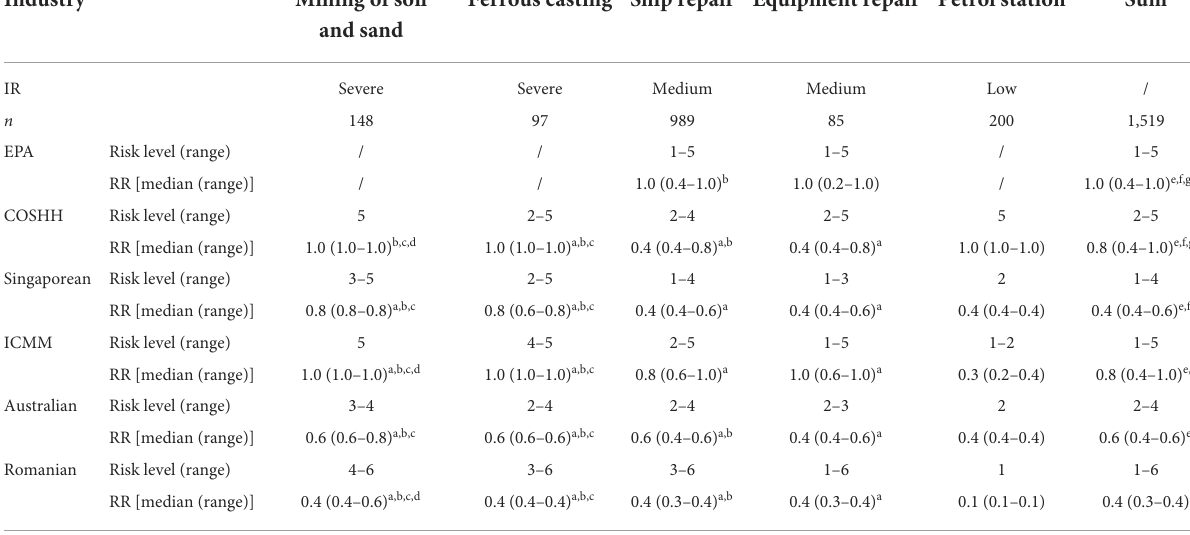
TABLE 4 Quantitative comparison of RRs among the six OHRA models in five